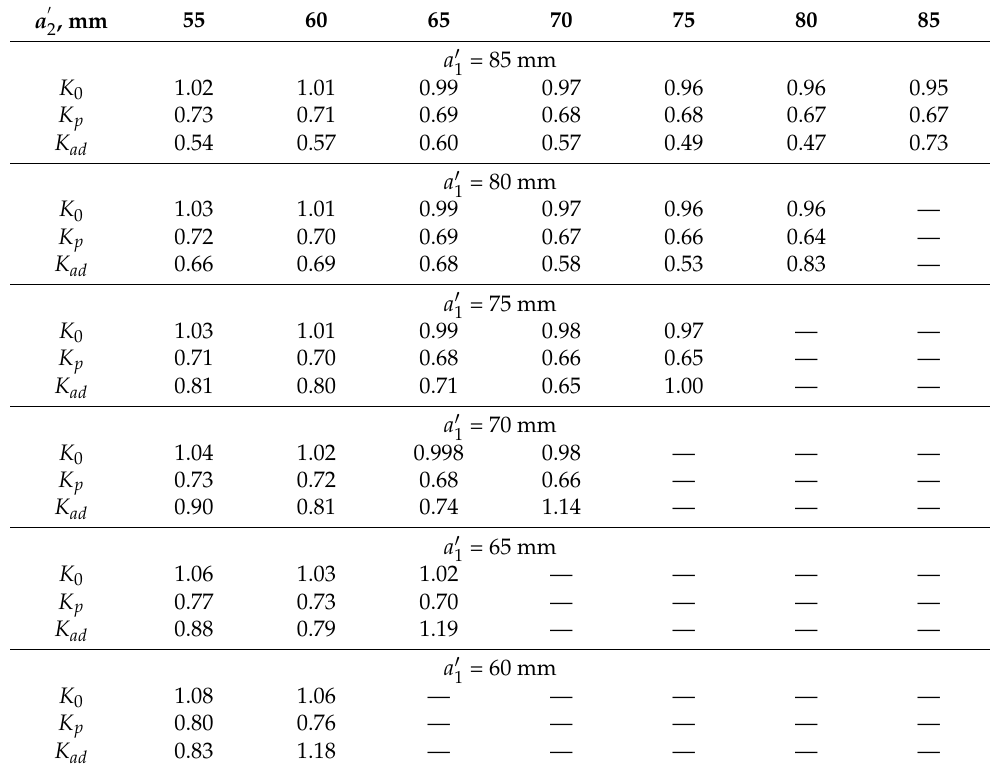
= δ (cid:48) = 0.1 2 1